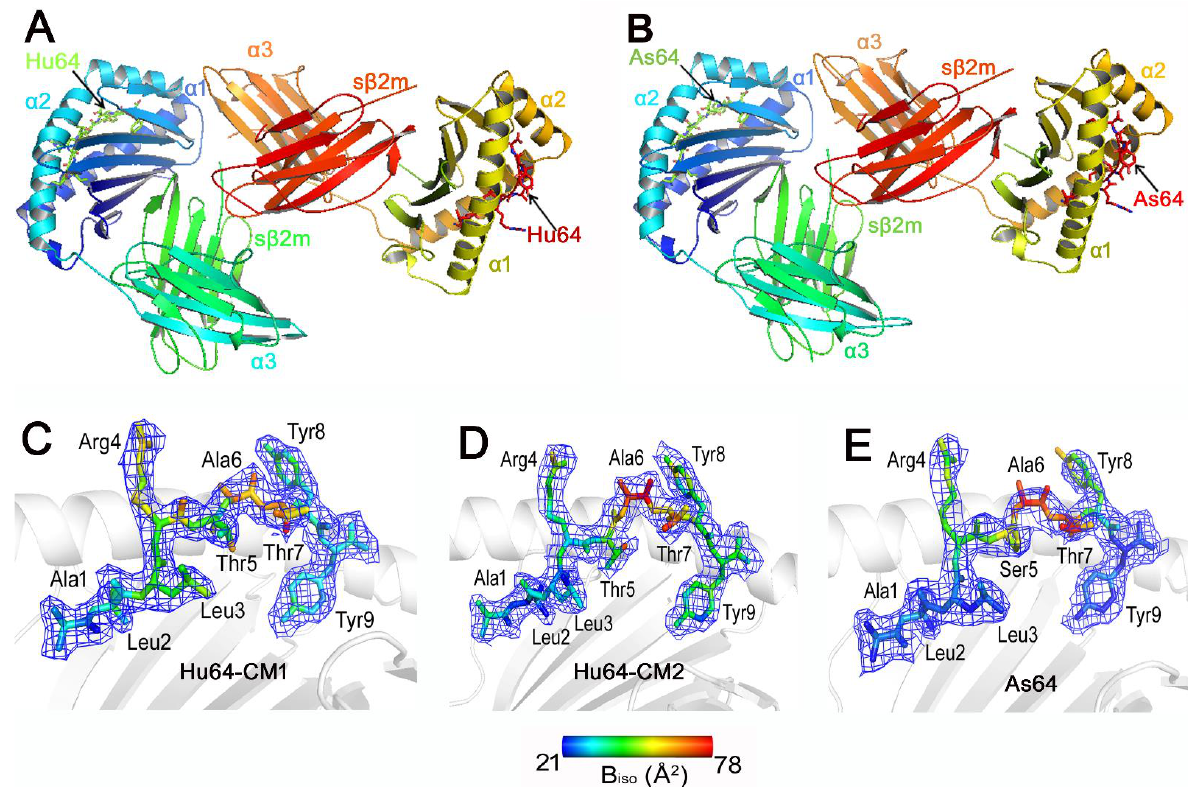
Figure 1. Analysis of the overall structure of SLA-2*HB01 and analysis of the conformations and flexibilities of peptides bound to SLA-2*HB01. The structure of ( A ) SLA-2*HB01–Hu64–s β 2 m; ( B ) SLA- 2*HB01–As64–s β 2 m. The conformation when peptide ( C ) Hu64-CM1, ( D ) Hu64-CM2, or ( E ) As64 are bound to the peptide-binding groove of SLA-2*HB01, presented with electron density at the 1.0- σ contour level. The flexibility of amino acids in different peptides are shown in different colors according to isotropic B